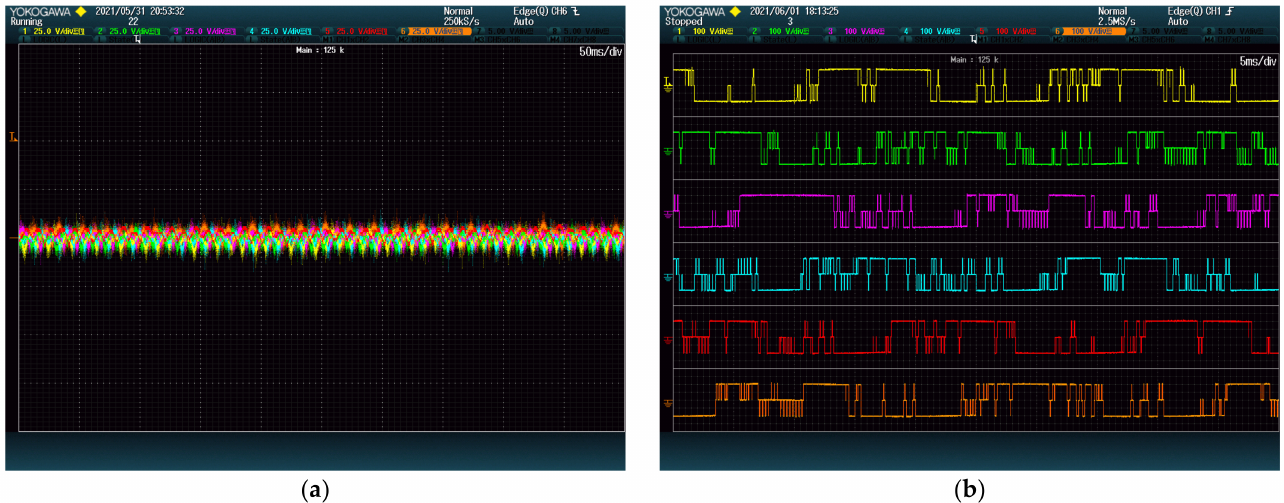
Figure 4. First test results, without switching reduction or power following objectives: ( a ) DC-link voltage ripple (25 V/dv) vs. time (50 ms/div); ( b ) Modules output voltages for 2.5 grid periods.